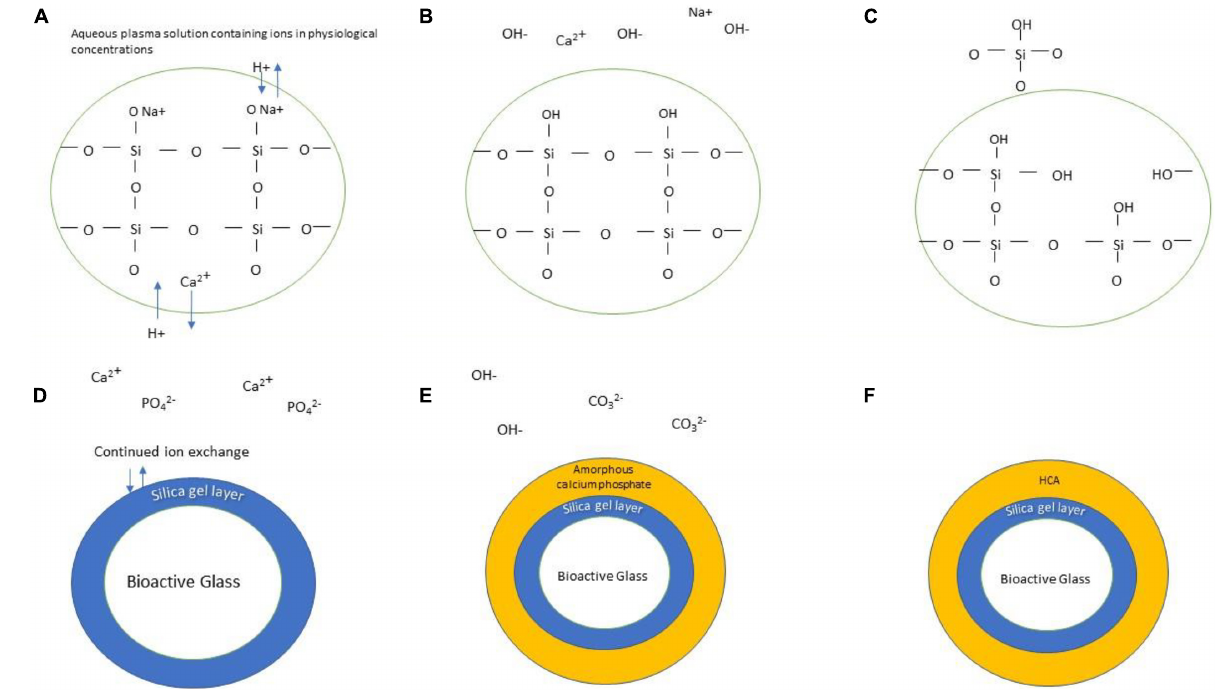
FIGURE 2 | Schematic illustration of the formation of HCA layer on the surface of bioactive glass. The stages are as follows: (A) Bioactive glass is submerged in physiological solution; Ionic exchange occurs between the doped ions and protons in the solution, forming hydroxyl groups (B) . Continuation of this process releases silicon in the form of silanol (C) . A silica gel layer is formed (D) which allows continued ion exchange of calcium and phosphate groups, forming an amorphous calcium phosphate layer atop the silica gel layer (E) . Continued incorporation of hydroxyl and carbonate groups results in the formation of an HCA layer (F)